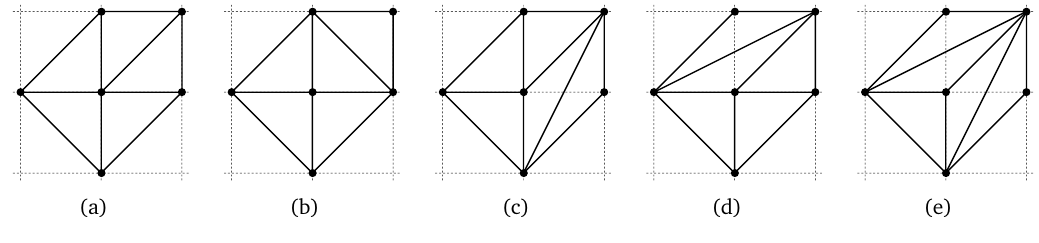
Figure 9: The five resolutions of the E